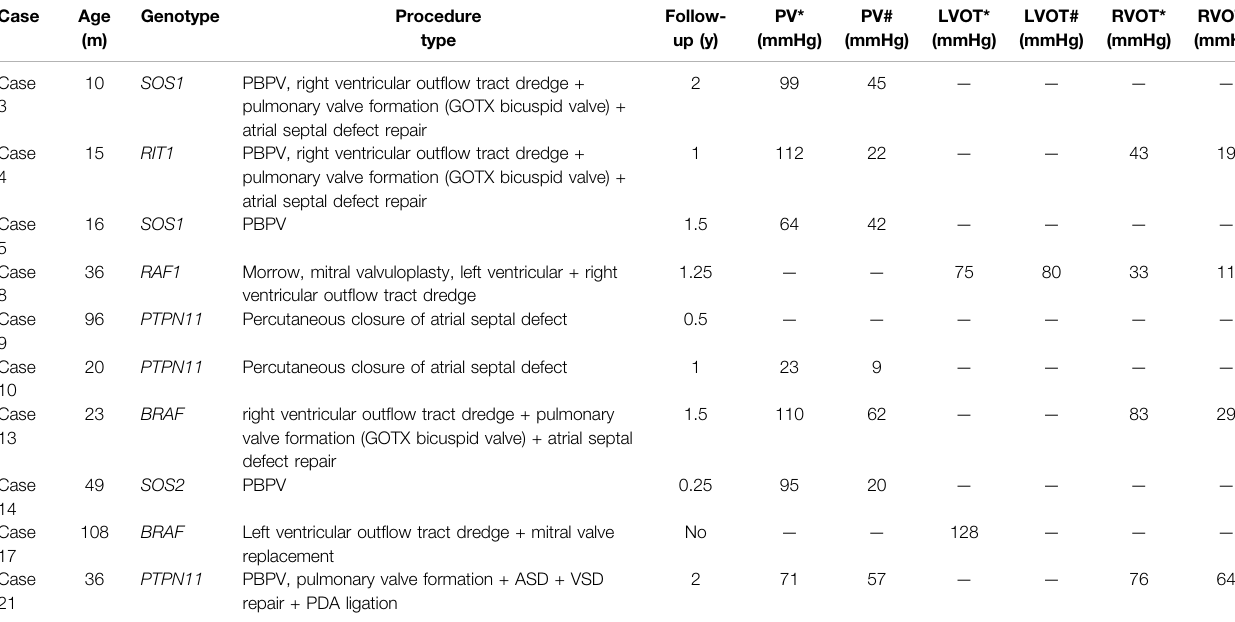
TABLE 3 | Catheter or surgery-based interventions and follow-up clinical data.